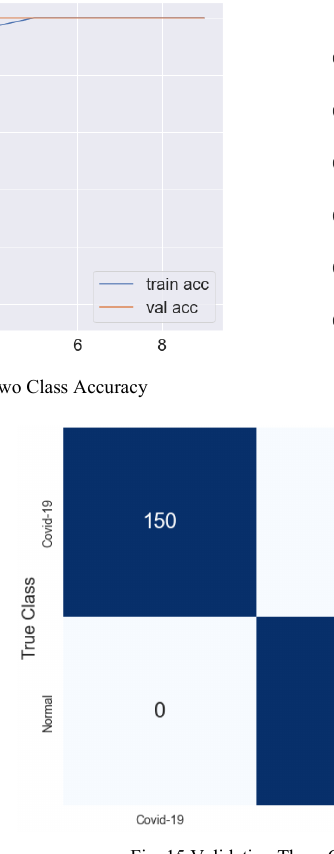
Fig. 15 Validation Three Class